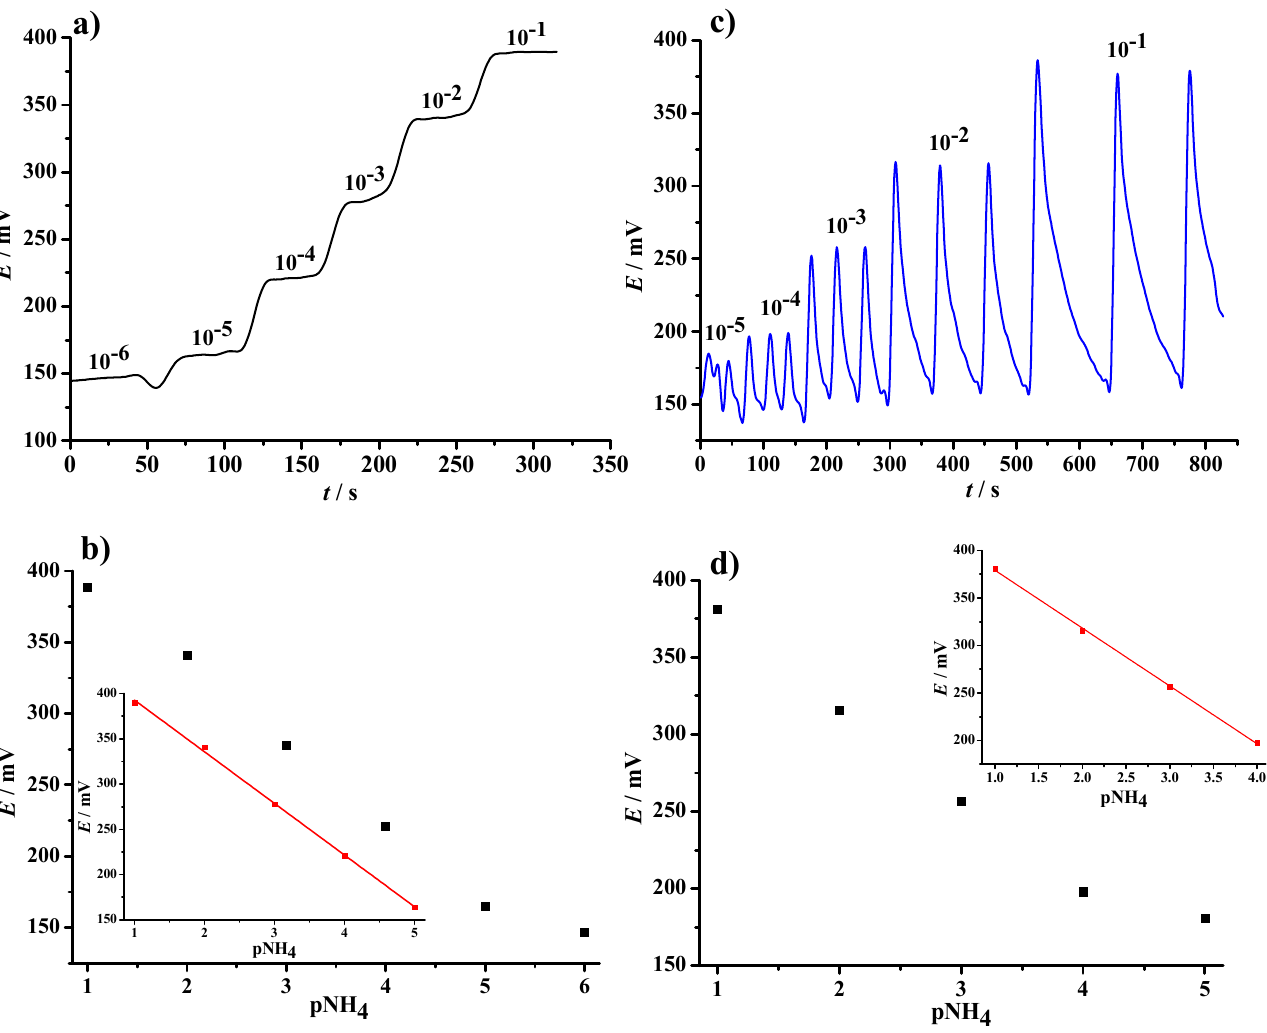
Figure 10. Time-dependence response of NH 4 selective paper sensor in a continuous flow ( a ) and injection flow conditions ( c ), obtained with a 0.833 mL/min flow rate of the carrier stream (10 − 6 M NH 4 Cl solution prepared in 10 mM CaCl 2 ). Corresponding dynamic and linear response plots ( b , d ) were also given. Table 3. Comparison of various nonactin-based potentiometric sensors for selective determination of NH 4 .